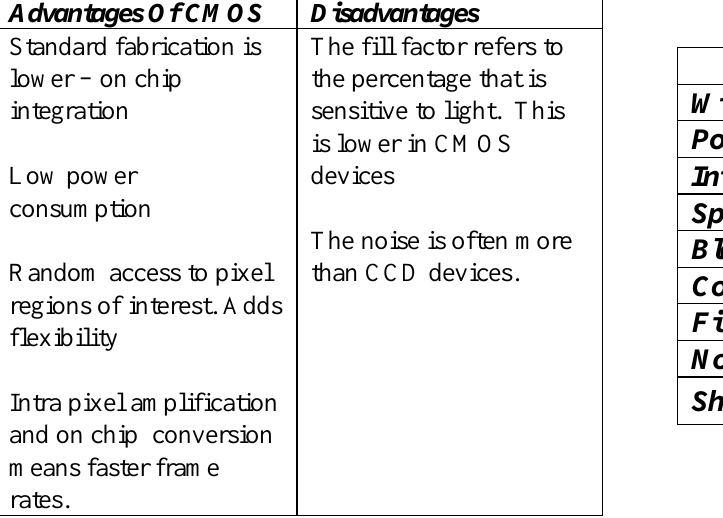
Figure 37. Comparison of CCD and CMOS